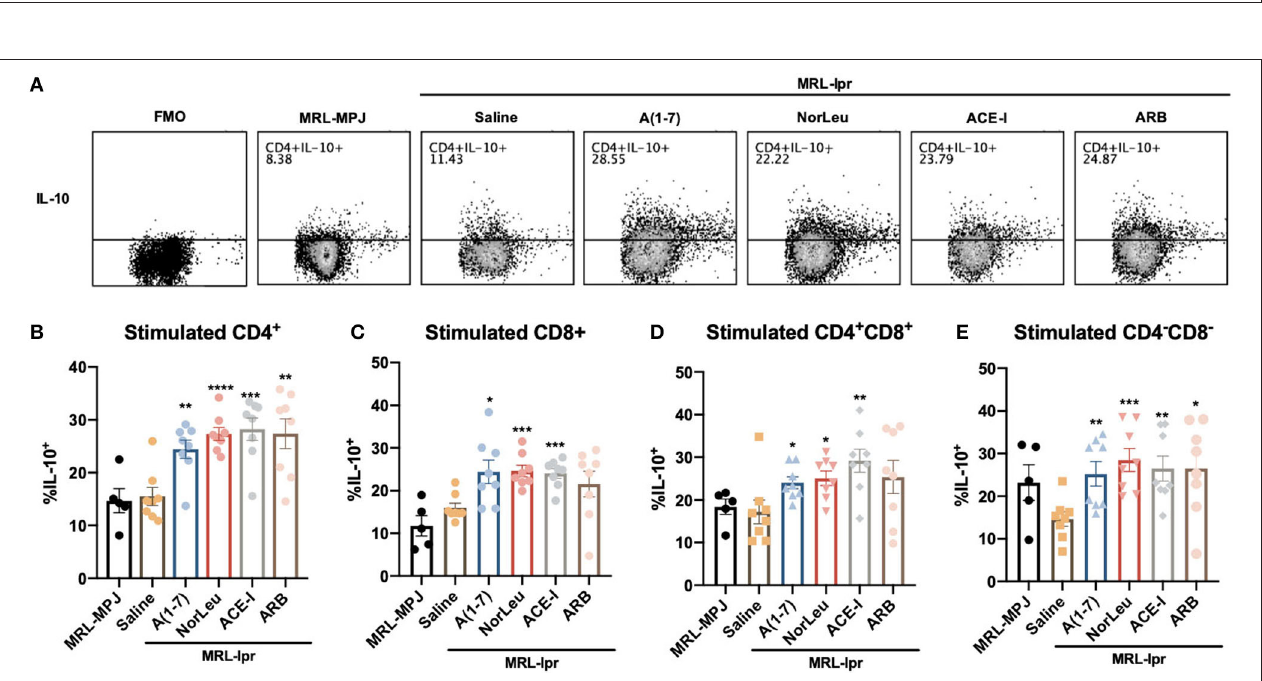
FIGURE 5 | IL-10 producing T cells are increased with RAS-modifying treatments. Splenic cells were stimulated for 16h with PMA/ionomycin and then stained with T cell markers and for IL-10 production. The gating strategy for the T cell characterization can be found in Supplemental Figure 7 . (A) Representative plots show samples of CD4 + T cells expressing IL-10 after stimulation, and an example of fluorescent minus one (FMO). The percent of (B) CD4 + and (C) CD8 + T cells that express IL-10 were measured. The percentage of cells producing IL-10 in the unusual (D) CD3 + CD4 − CD8 − and (E) CD3 + CD4 + CD8 + populations were also measured. Statistics were run using Prism 8.4.0, t -tests were used to compare all groups to saline treated MRL -lpr mice; * p ≤ 0.05, ** p ≤ 0.01, *** p ≤ 0.001, **** p ≤ 0.0001.